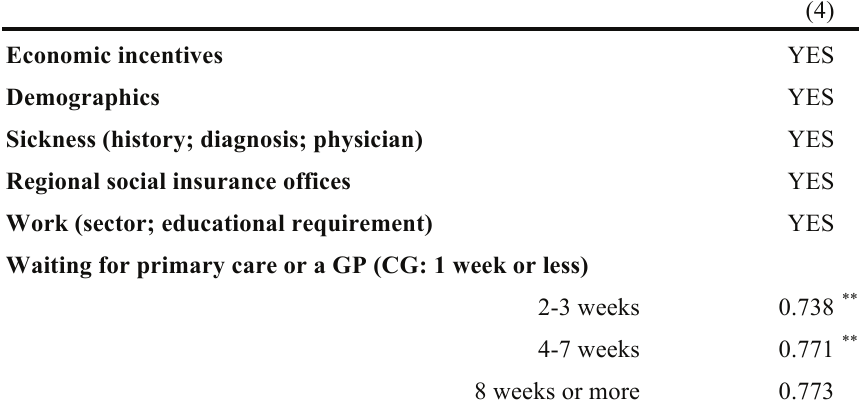
Table 1c: Hazard ratio estimates: waiting times parameters Economic